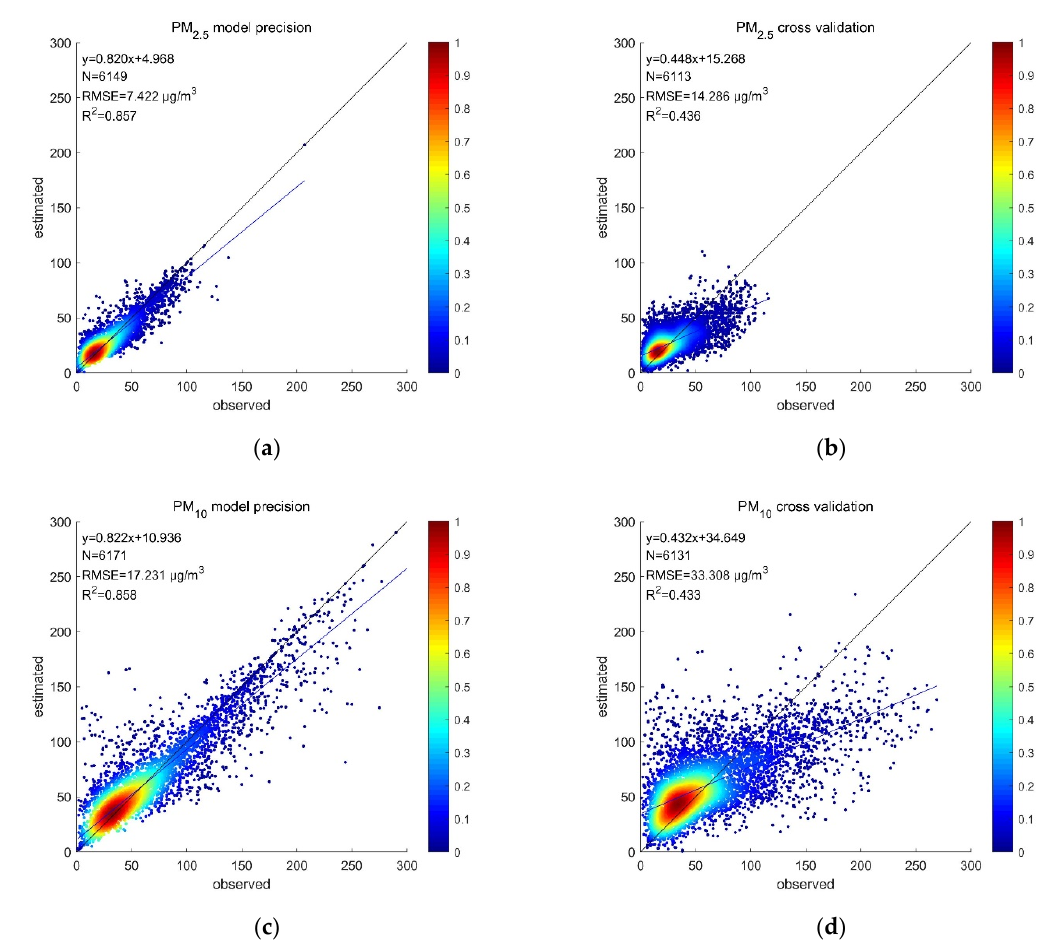
Figure 3. Scatter plots for ( a ) model fitting result and ( b ) tenfold cross-validation results for PM 2 . 5 . Scatter plots for ( c ) model fitting result and ( d ) tenfold cross-validation results for PM 10 . The colour represents the sample density. This part is calculated using land use data instead of NDVI.